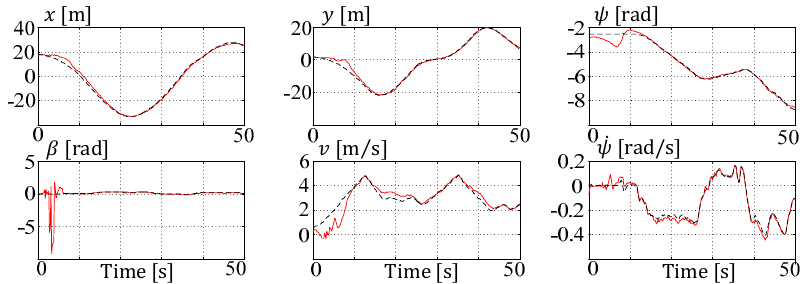
Figure 17. Extended single track model (ESTM) square-root extended Kalman filter (SR-EKF) ( n d = 1) setup state estimations (red) vs. reference (black).